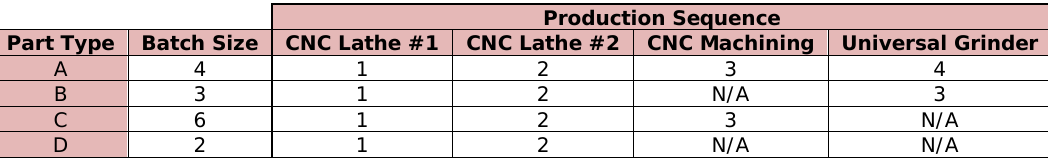
Table 2. “Part family characteristics and sequence of stations for each part